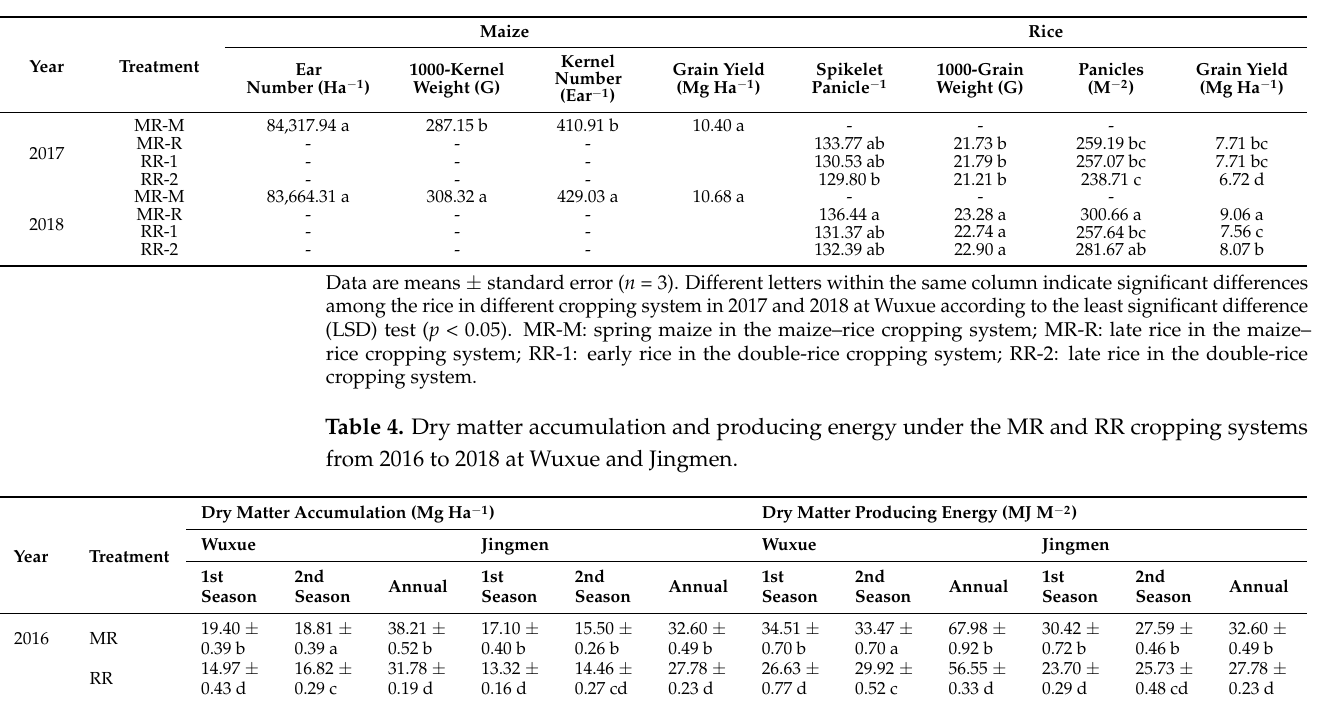
Table 3. Yield and yield components of maize and rice in 2017 and 2018 at Wuxue.